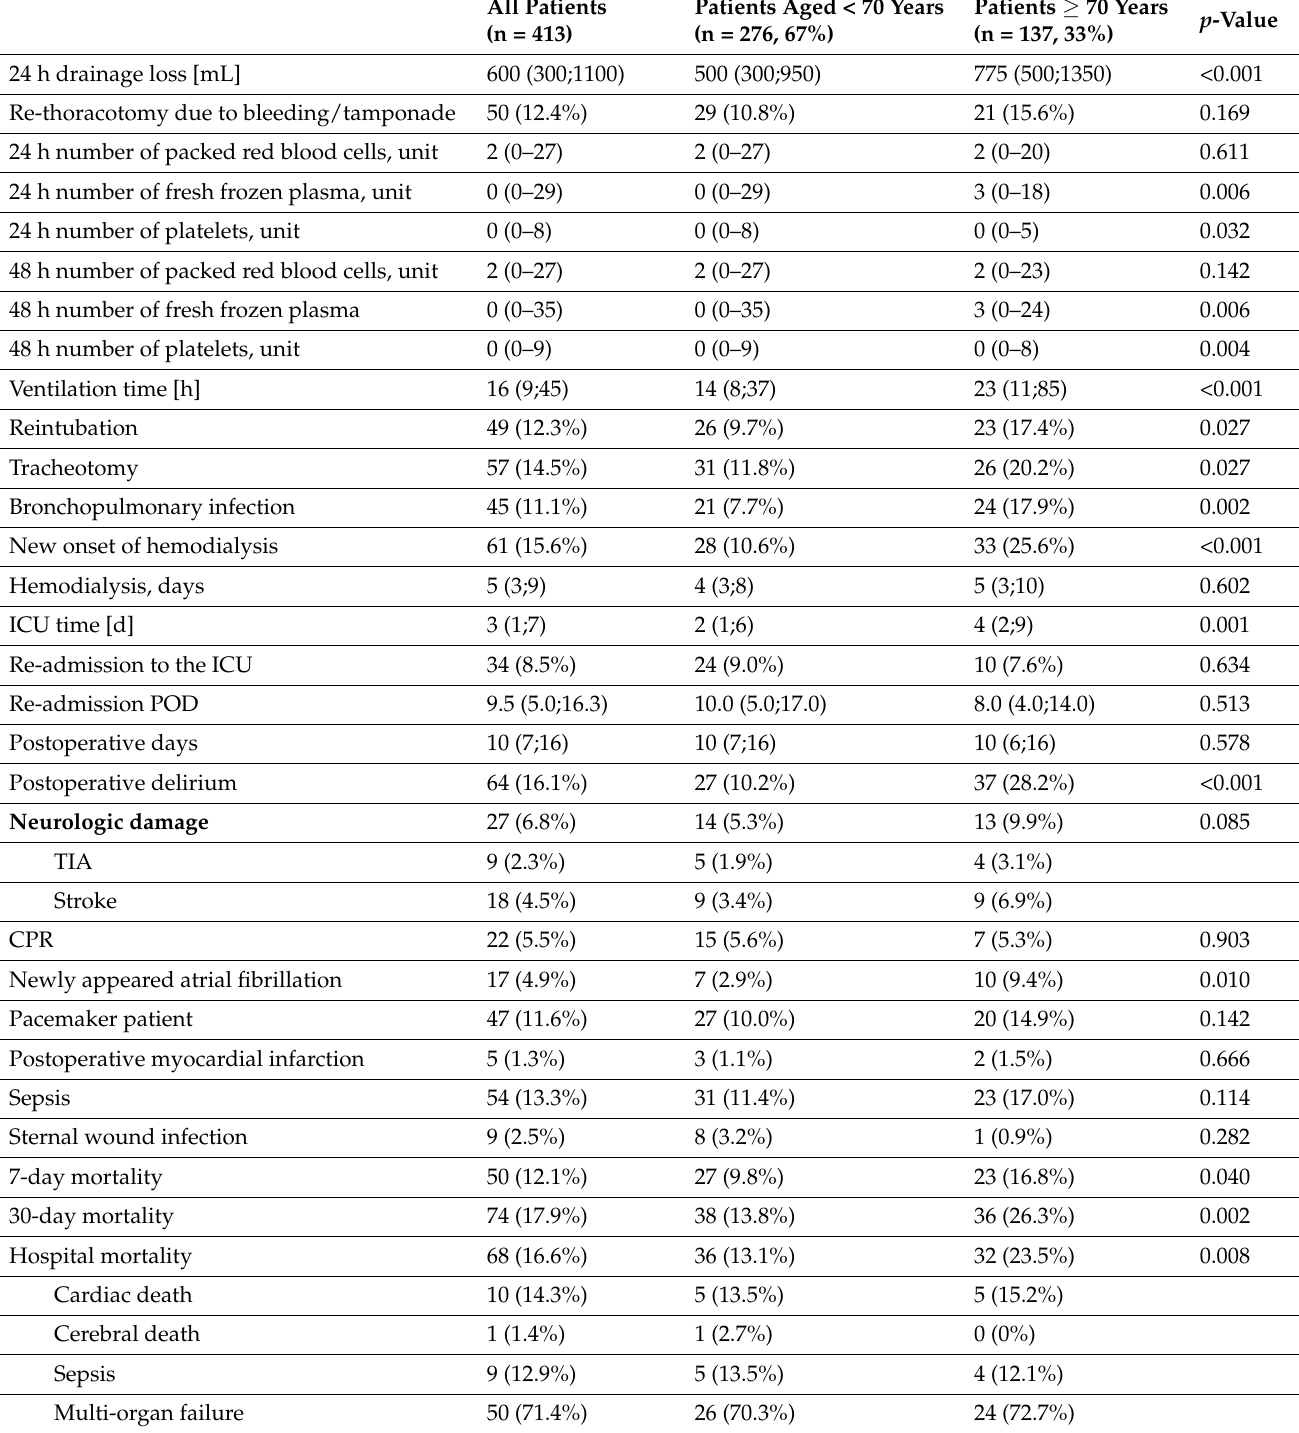
Table 4. Postoperative data and primary